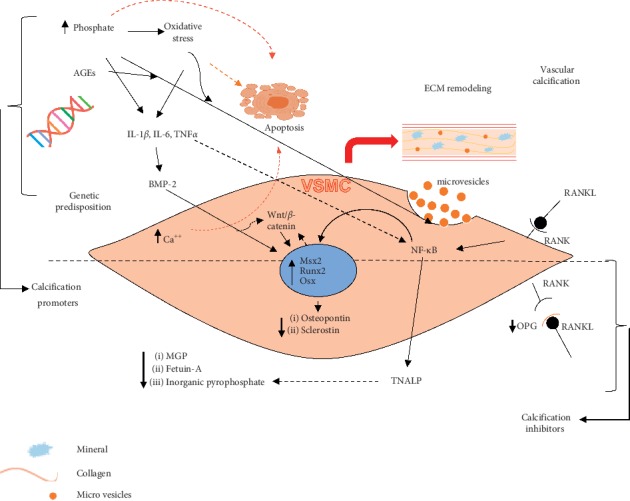
Pathophysiological mechanisms which promote cellular differentiation and vascular calcification. AGEs, advanced glycation end products; VSMC, vascular smooth muscle cell; BMP, bone morphogenetic protein; Runx2, runt-related transcription factor 2; Msx2, msh homeobox 2; IL-1β, interleukin-1beta; IL-6, interleukin-6; TNFα, tumor necrosis factor alpha; NF-κB, nuclear factor kappa-light-chain-enhancer of activated B cells; RANK, receptor activator of nuclear factor kappa-B; RANKL, receptor activator of nuclear factor kappa-B ligand; ECM, extracellular matrix; OPG, osteoprotegerin; MGP, matrix gla protein; TNALP, tissue nonspecific alkaline phosphatase.